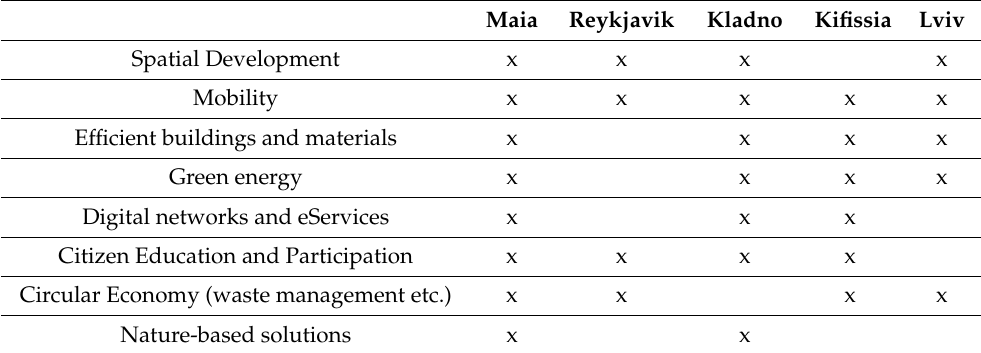
Table 4. Key strategy areas identified through the City Vision 2050 (improved and adapted from